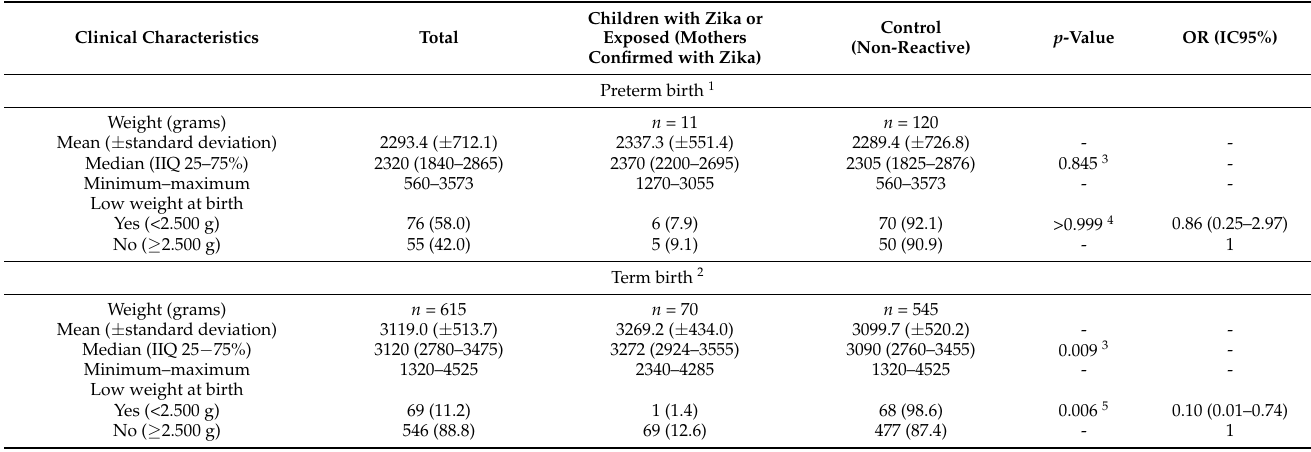
Table 4. Comparison of low birth weight and gestational age in the newborn groups (exposed/positive) versus control, Jundia í Medical School,